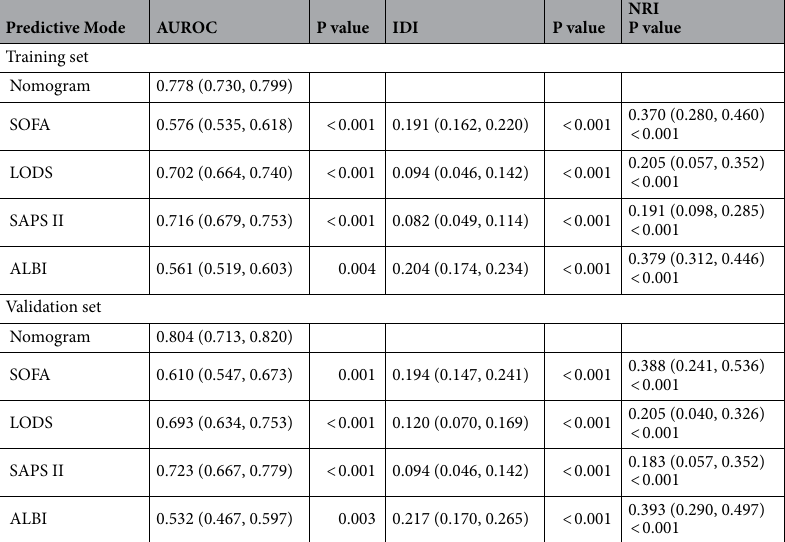
Table 3. Comparison of models for predicting the 90-day mortality of SALI.